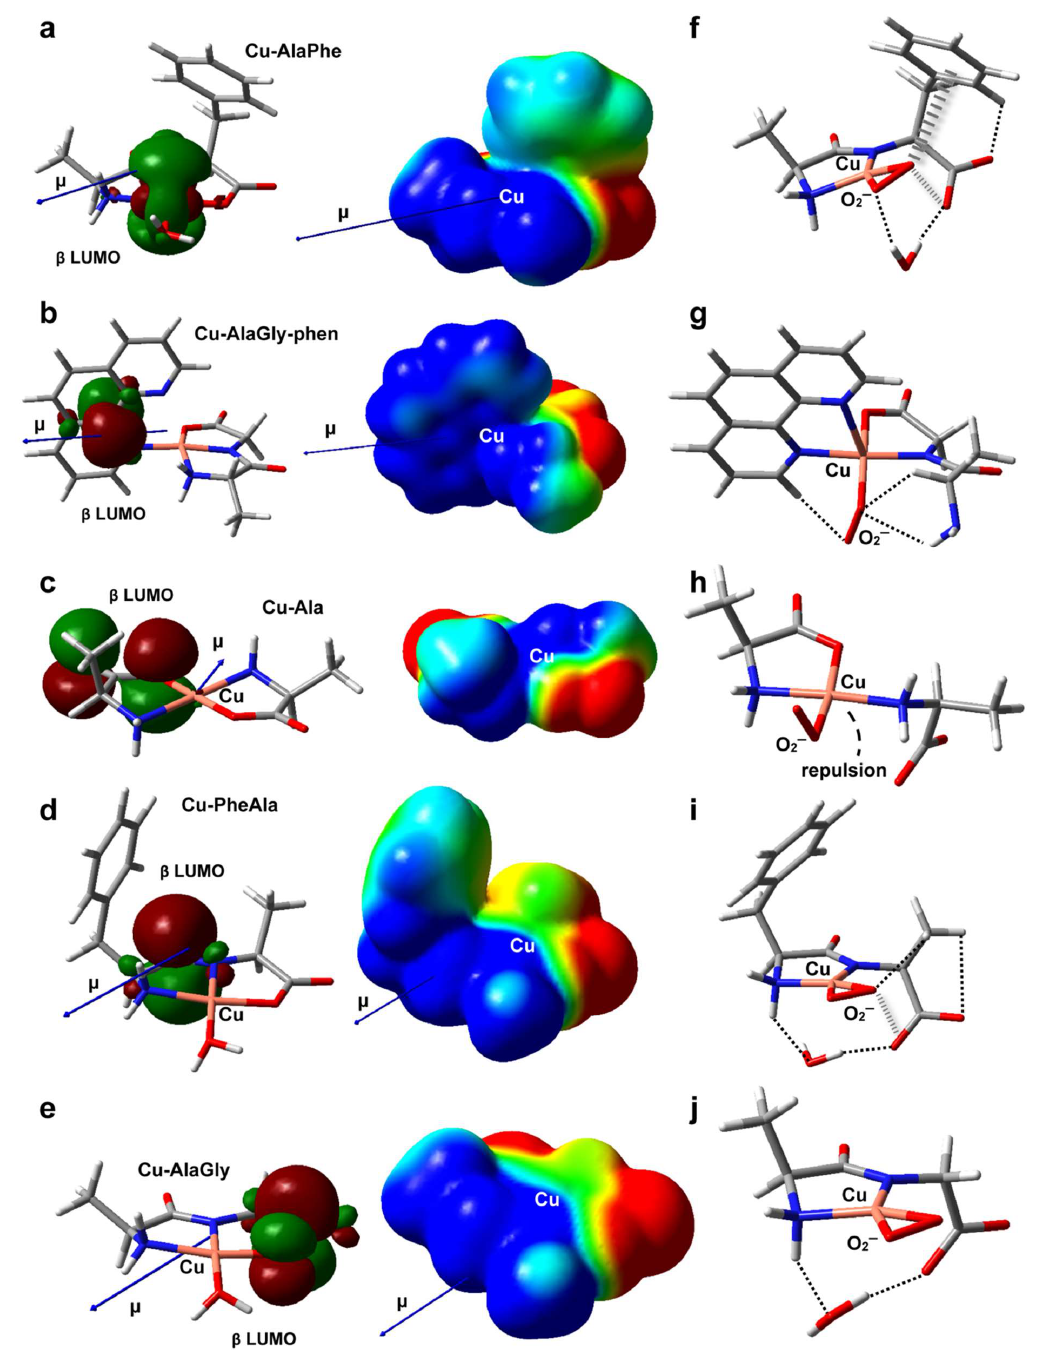
Figure 5. DFT-optimized geometries in aqueous solution of Cu–AlaPhe) ( a ), Cu–AlaGly)–phen ( b ), Cu–Ala ( c ), Cu–PheAla) ( d ) and Cu–AlaGly ( e ). The electric dipole moment vector ( µ ), the β LUMO spatial distribution and the electrostatic potential mapped onto an isodensity surface (isodensity value = 0.001 e; scale = −50 (red) to +50 (blue) mV) are also shown. In ( f – j ), the optimized structures of the corresponding superoxide complexes are depicted, with the noncovalent intramolecular interactions represented as dashed (H-bonds) or hatched (anion-π interactions) lines. Atom color code: C (gray), H (white), N (blue), O (red), Cu (pink).